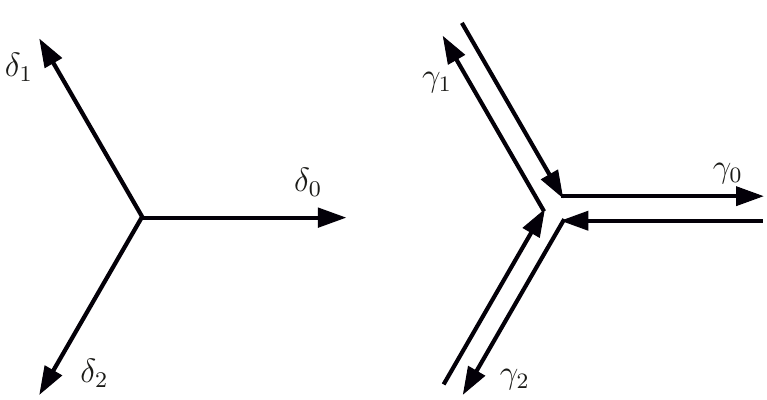
Figure 1 . The integration cycles in a single variable Landau-Ginzburg model with worldsheet superpotential W = x 3